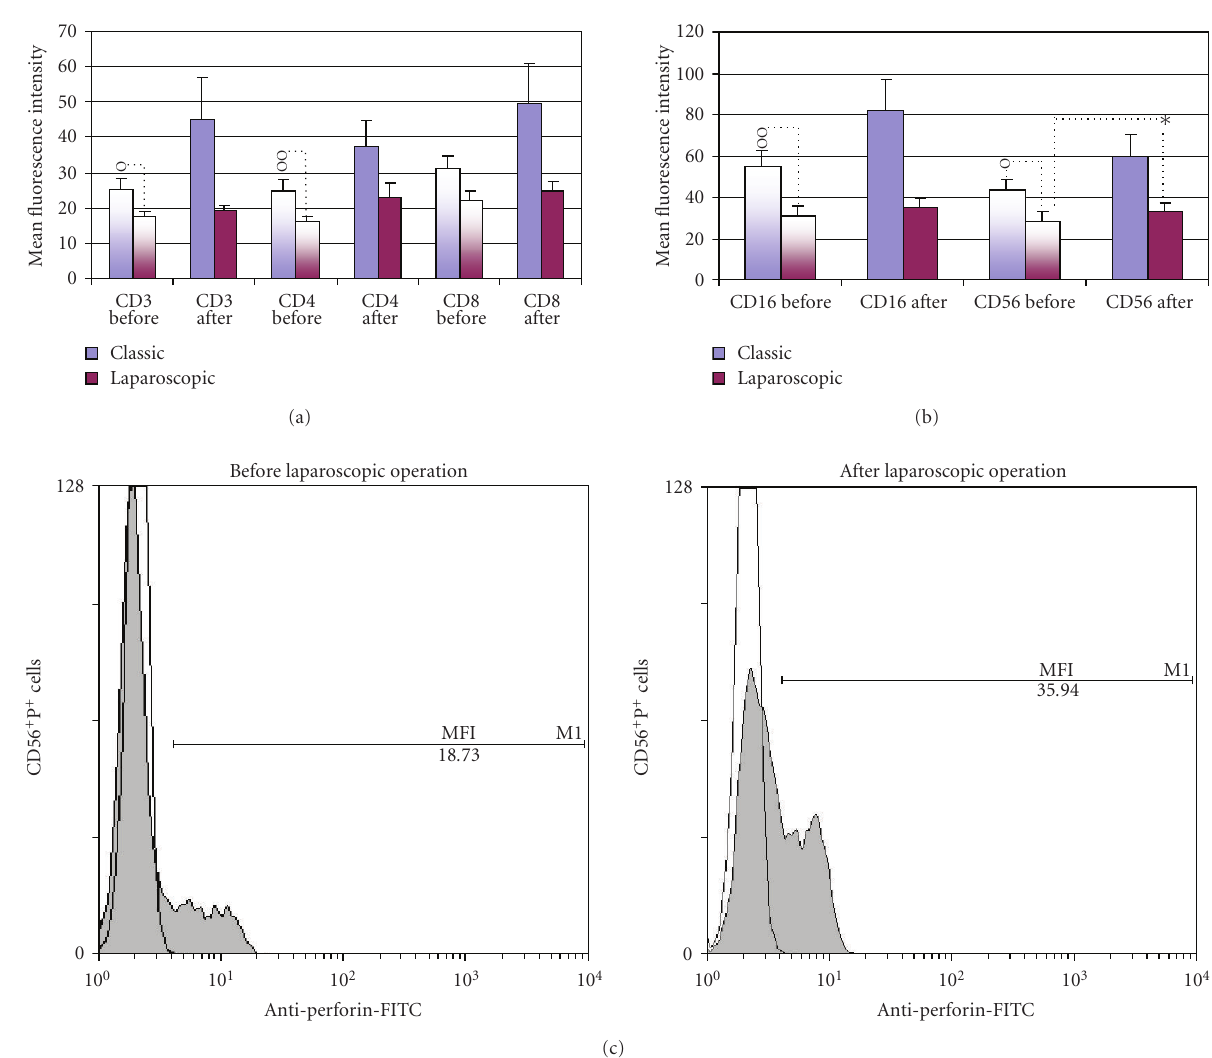
Figure 5: The levels of P expression (mean fluorescence intensity; MFI values) for (a) T lymphocytes (CD3 + P + ) and their subpopulations (CD4 + P + and CD8 + P + ), and (b) NK cells (CD16 + P + and CD56 + P + ) in peripheral blood from patients subjected to classic or laparoscopic cholecystectomy before (two-colored columns) and after the operation (one-colored column). O-statistical significance between the preoperative values in classic and laparoscopic cholecystectomy; ∗ statistical significance between the preoperative and postoperative values in classic or laparoscopic cholecystectomy. One mark P < . 05, two marks P < . 01. (c) Representative flow cytometric profile of perforin expression on the gated CD56 + PBMNLC before and 24 hours after laparoscopic cholecystectomy. The shadow area was perforin expression while the nonshadow area was isotype control. The amount of perforin per cell is indicated by the mean fluorescence intensity